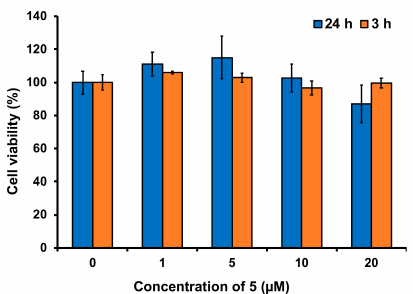
Figure 9. Cell viability values (%) estimated by MTT proliferation test versus incubation concentrations of 5 . HepG2 cells were cultured in the presence of 5 (1–20 µ M) at 37 ◦ C for 3 h (orange bars) and 24 h (blue bars).